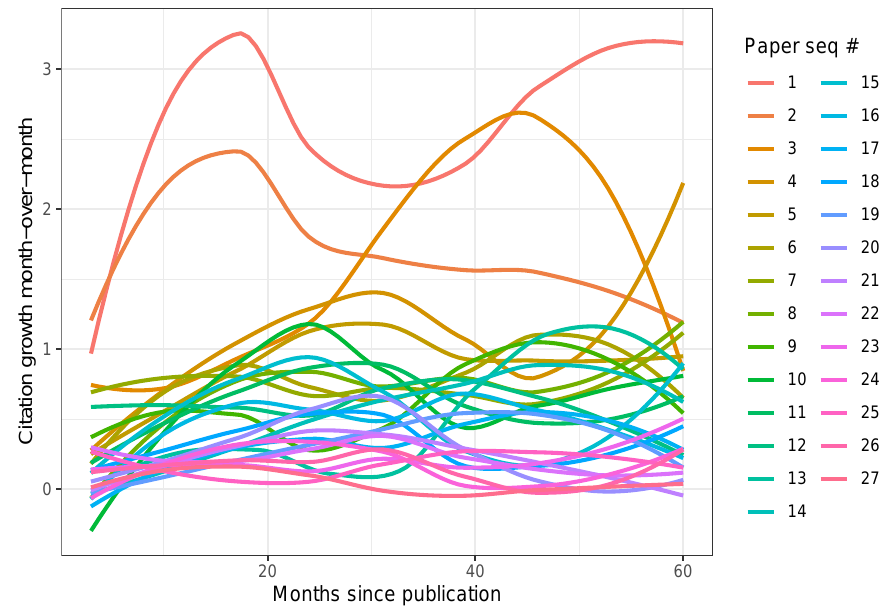
Figure 3. Monthly citation growth over five years using LOESS